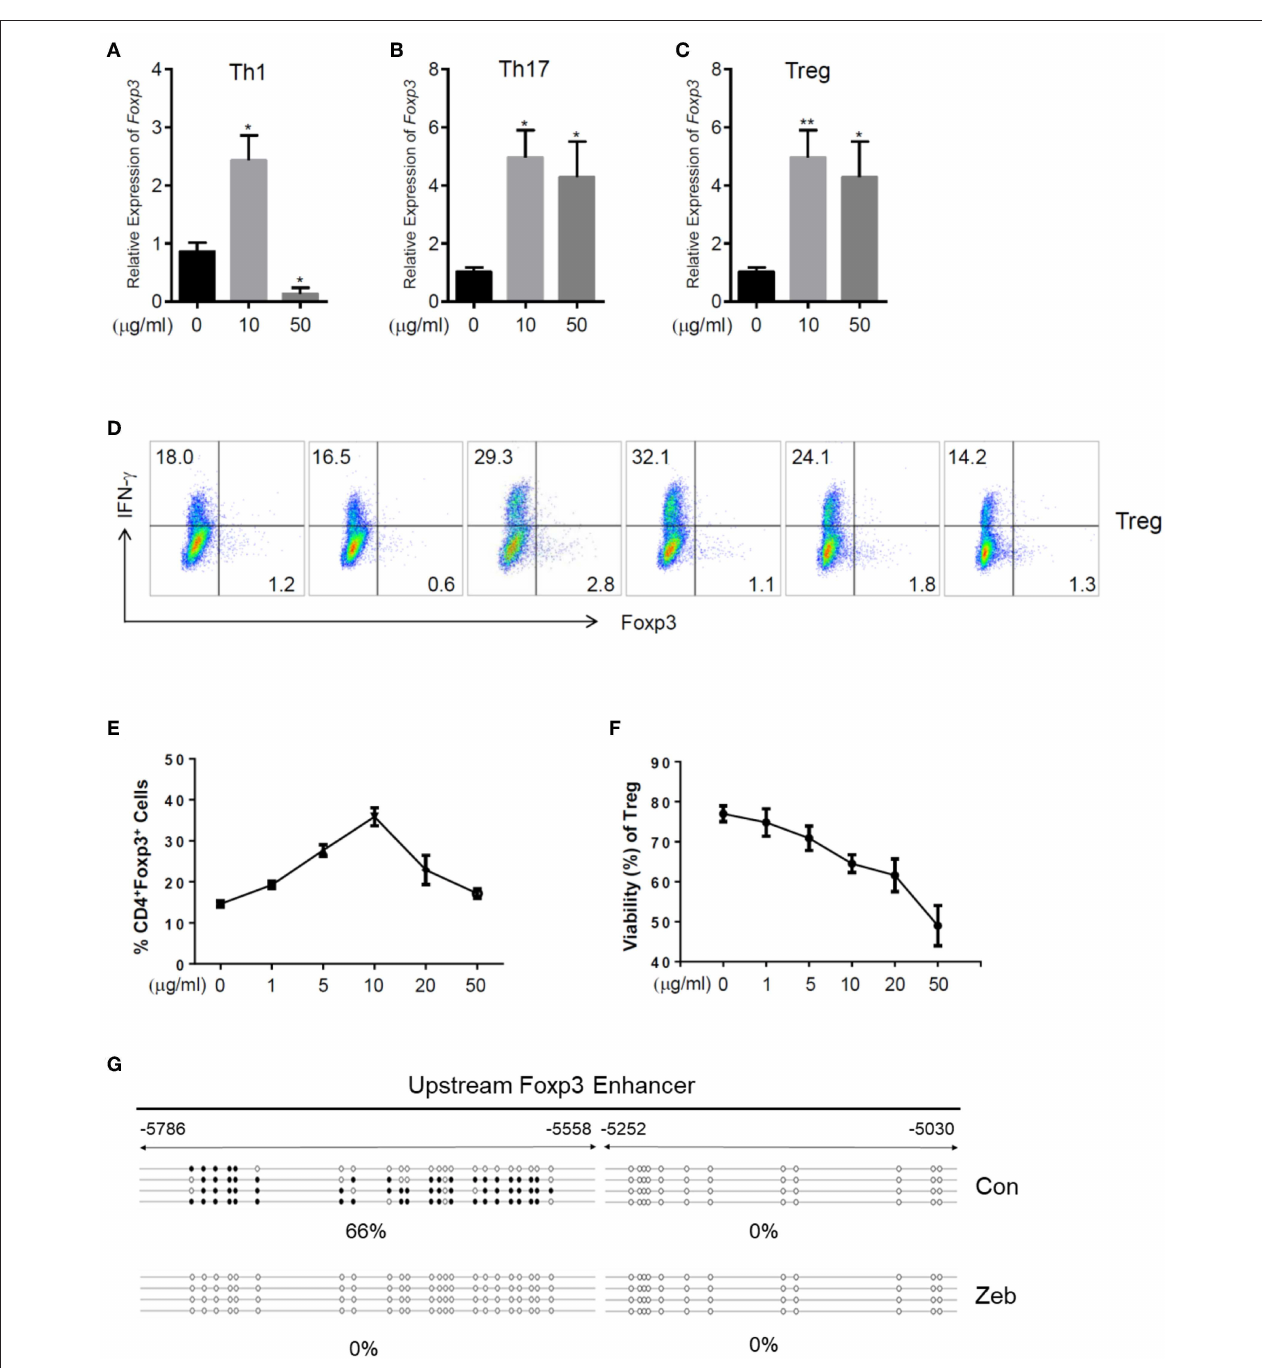
FIGURE 5 | Zebularine promotes the expression of Foxp3 in murine CD4 + T cells in vitro . (A–C) The relative RNA expression of Foxp3 in zebularine-treated murine Th1, Th17 and Treg cells * P < 0.05; ** P < 0.01. (D) Representative dot plots ( N = 5) for murine Treg cells stained with IFN- γ and Foxp3. (E) The percentages of Foxp3 + cells in zebularine-treated murine CD4 + T cells. Means ± SD are shown. (F) Viability of murine Treg cells treated with different doses of zebularine. Means ± SD are shown. (G) Methylation status of the CpG islands located in Foxp3 enhancer in murine Treg cells treated with zebularine or vehicle. •, methylated CpG; ◦ , unmethylated